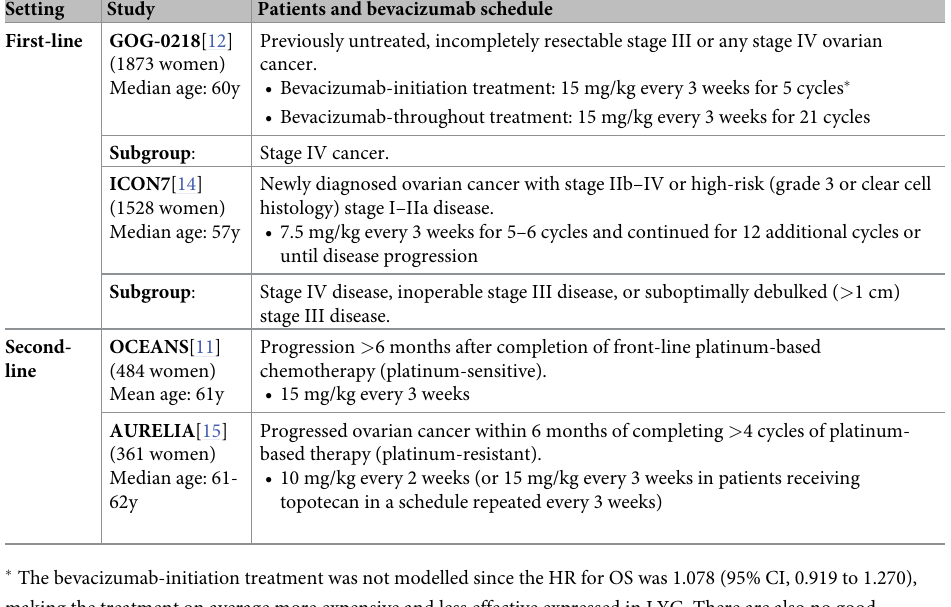
Table 1. Eligible patient population and bevacizumab treatment schedules in 4 peer-reviewed